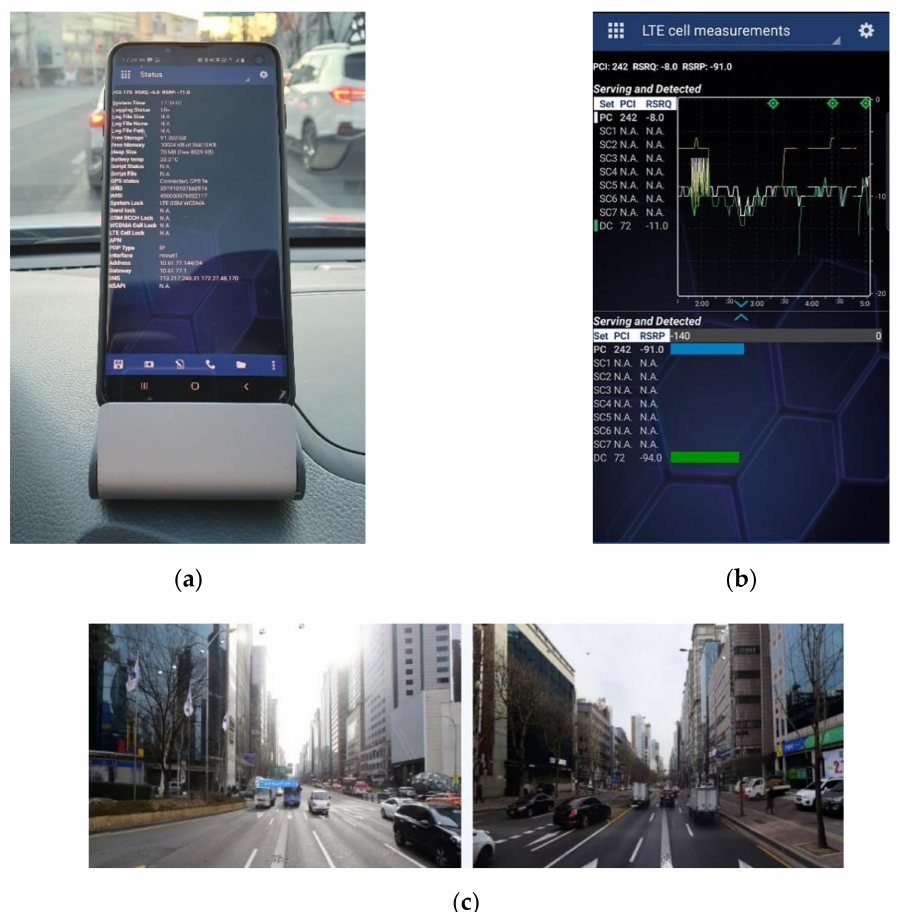
Figure 5. Measurement equipment and experimental environment. ( a ) LTE signal acquisition equipment; ( b ) an example of signal information obtained from Nemo Handy; ( c ) test environment viewed from the vehicle during the signal acquisition